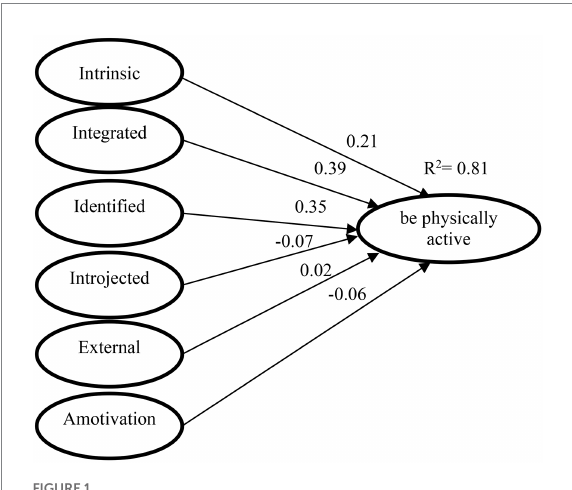
FIGURE 1 Model supporting regulators of motivation to be physically active.